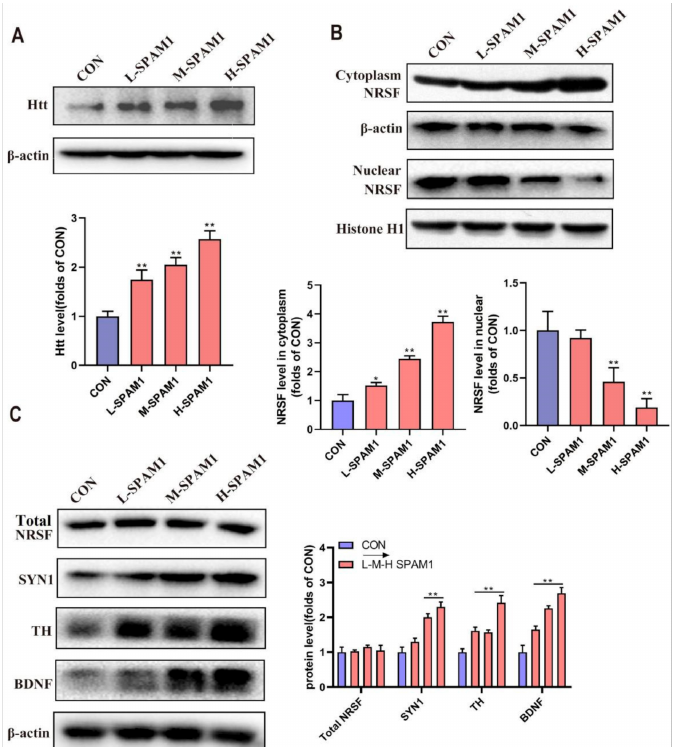
Figure 9. The effect of SPAM1 on Htt level, on the distribution of NRSF between cytoplasma and nuclear and on the expression level of neuropeptides including SYN1, TH, and BDNF in RGC-5 cells. ( A ) The WB images of Htt in whole RGC-5 cells incubated with SPAM1 in concentration from 0.01 uM to 1 uM ( up ) and the corresponding statistical analysis ( down ) showed that level of Htt increased following the increase in the SPAM1 concentration. ( B ) The WB images of NRSF in cytoplasma and nuclear ( up ) and the corresponding statistical analysis ( down ) showed cytoplasm NRSF level increased following the treatment with SPAM1 and nuclear NRSF level have an opposite trend in SPAM1 concentration-dependent manner. ( C ) The Western blot results ( left ) and the subsequent quantitative analysis ( right ) demonstrated that SYN1, TH, and BDNF were significantly up-regulated by SPAM1 following the increase in SPAM1 concentration. No change in the whole cellular NRSF (total NRSF) levels was observed, indicating that SPAM1 does not interfere with the expression of NRSF, but influences the distribution of NRSF between cytoplasma and nuclear. *, p < 0.05, vs. CON; **, p < 0.01, vs. CON. Data are presented as the mean ± SEM of three